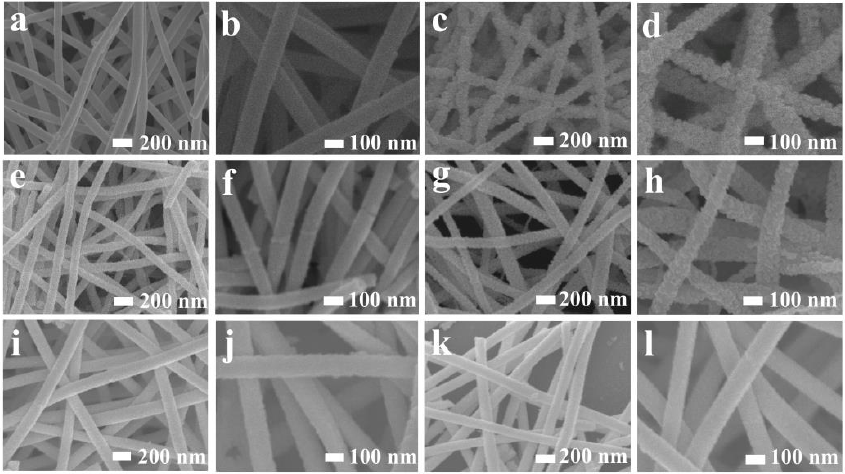
and out of the sensing body, which can ensure the high utility ratio of the gas sensors.